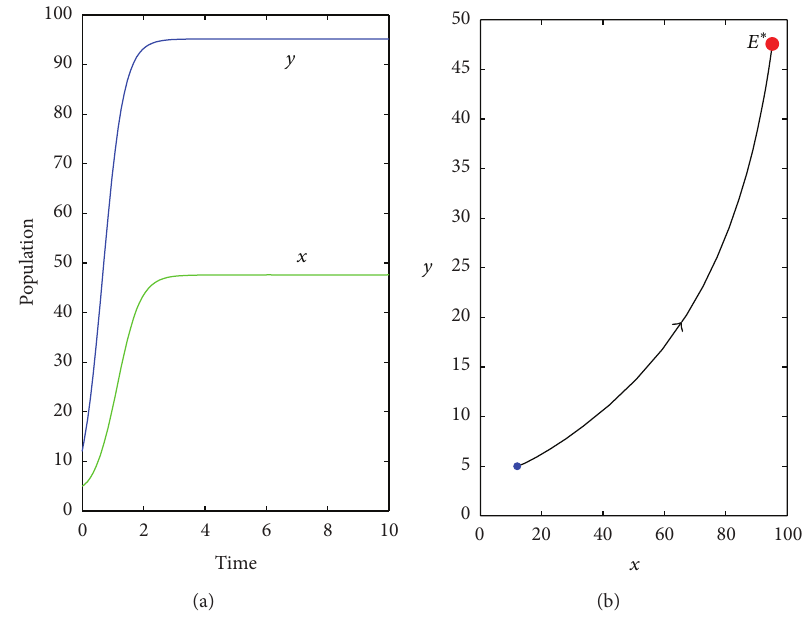
Figure 8: Biological control of chaos with increasing refuge 𝑚 = 0.6 . Other parameters are as in Figure